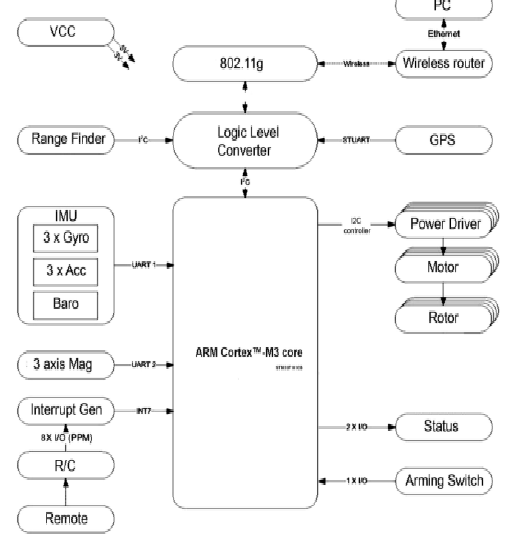
Figure 9. The NGC Block diagram